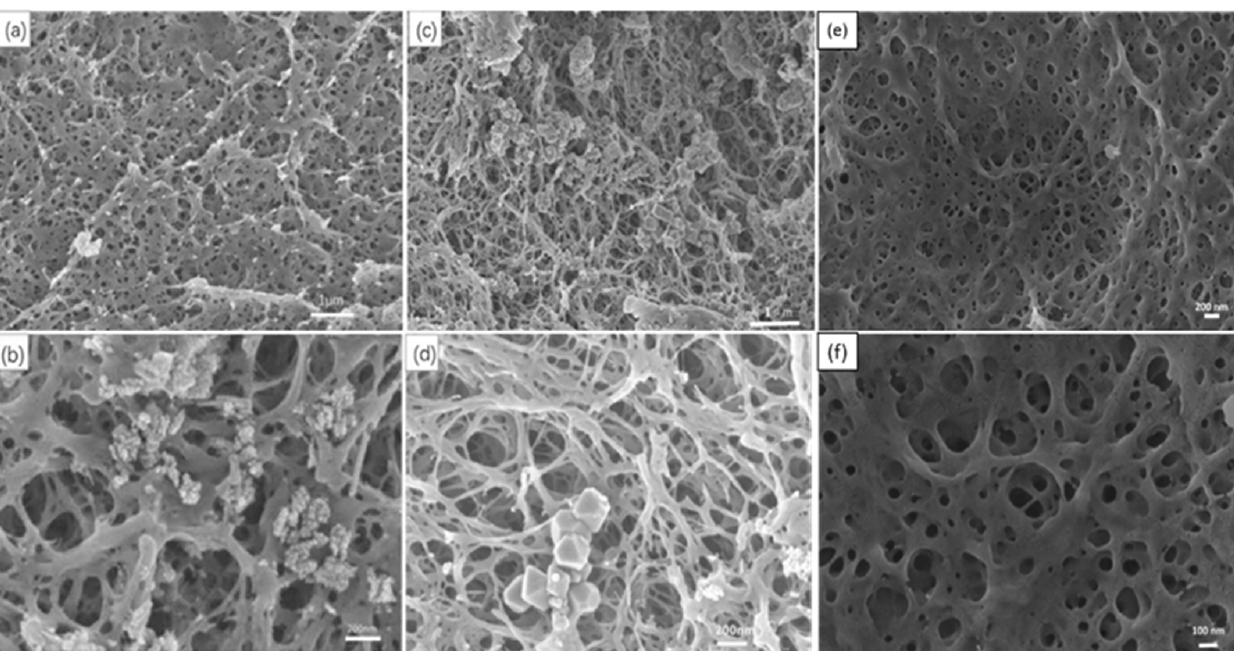
Figure 1. SEM image of iron-based/chitin composite membrane material (( a , b ), FeS/chitin; ( c , d ), Fe 3 O 4 /chitin; ( e , f ) pure chitin).